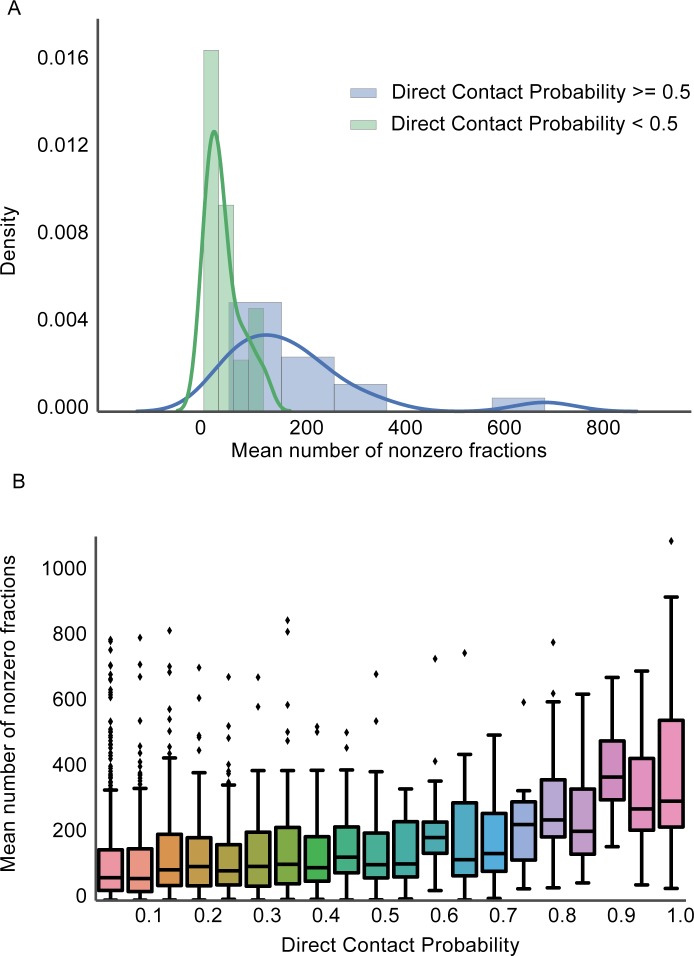
The direct contact prediction method makes high confident predictions for well-sampled complexes.A. Distribution of protein subunit sampling for complexes with a max direct contact probability > = 0.5 (blue) and complexes with a max probability < 0.5 (green). Sampling is measured for a complex by averaging the number of fractions for which each protein in the complex is observed (i.e. nonzero fractions). Our method performs better for well-sampled complexes and is limited for poorly sampled ones. B. Distribution of the mean number of nonzero fractions for pairs of proteins predicted by the direct contact method. Pairs of proteins with high probabilities are well sampled compared to those with lower probabilities.